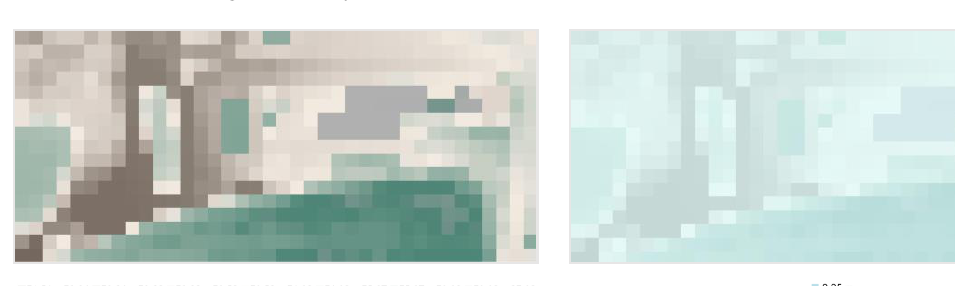
Figure 15. Comparison of the downsized model with the original model: ( a ) flood hazard map of the downsized model for a 100-year rain event with a duration of one hour generated by LISFLOOD-FP; ( b ) flood hazard map of the original model for a 100-year rain event with a duration of one hour generated by LISFLOOD-FP.